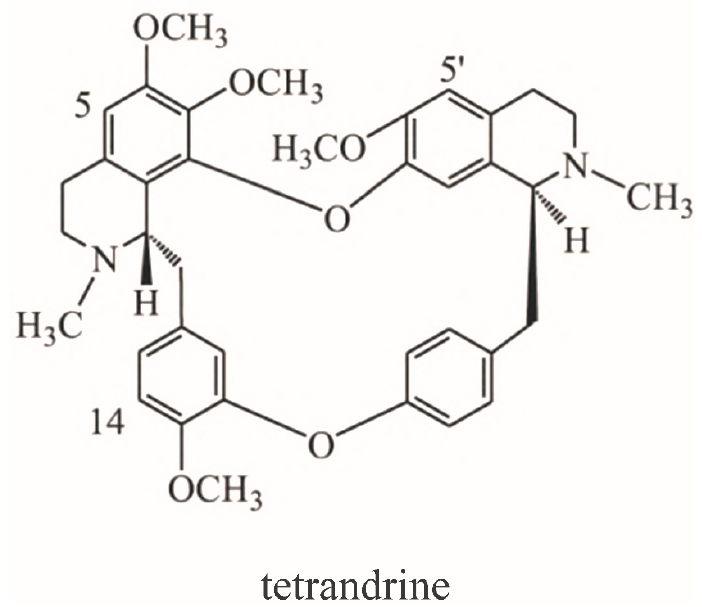
Figure 1. Chemical structure of tetrandrine.